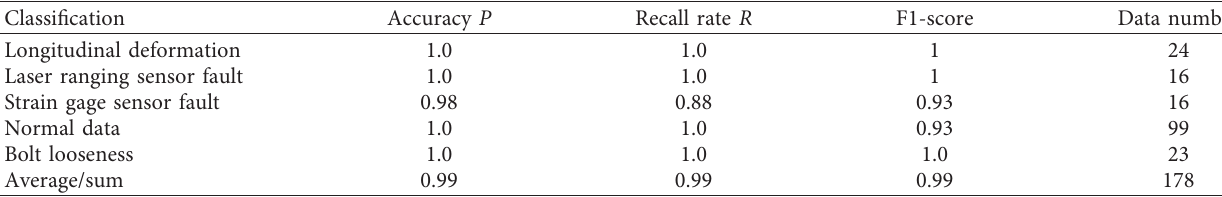
Figure 8: Grid search method parameter optimization. After parameter optimization, classification result and confusion matrix of RBF- SVM algorithm can be obtained as shown in Tables 6 and 7. Table 6: Fault diagnosis result of RBF-SVM.